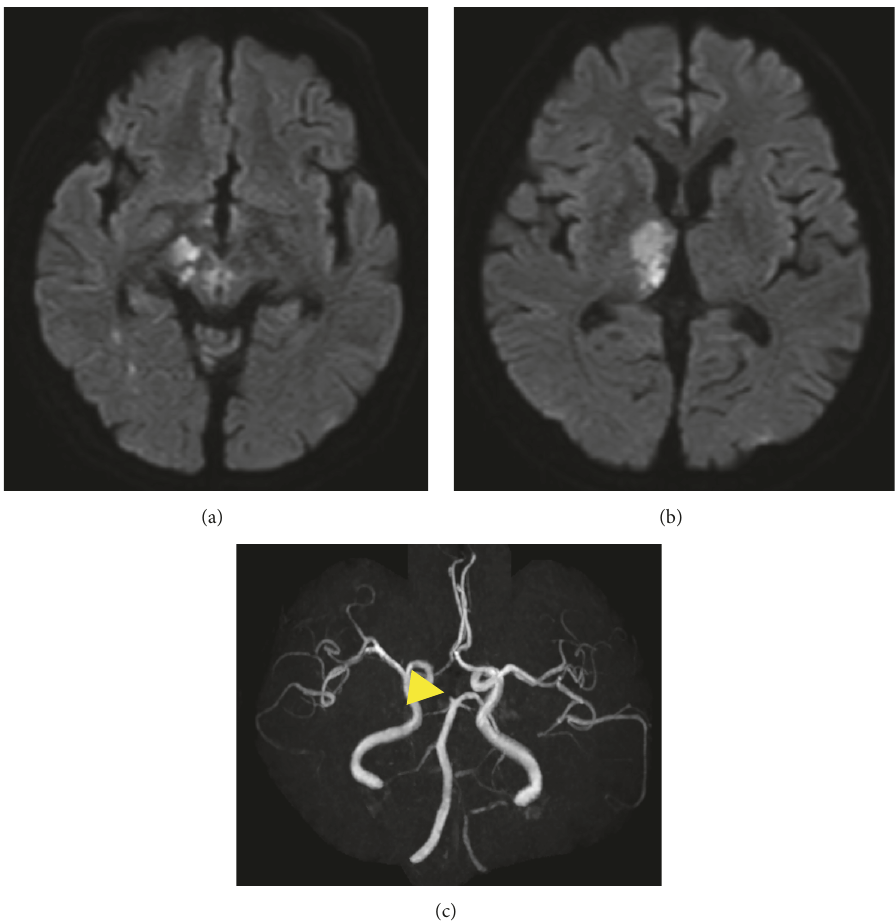
Figure 2: Head MRI performed after aggravation of neurological symptoms showed enlargement of infarction (a, b). MRA showed extension of occlusion (arrow head) to the P1